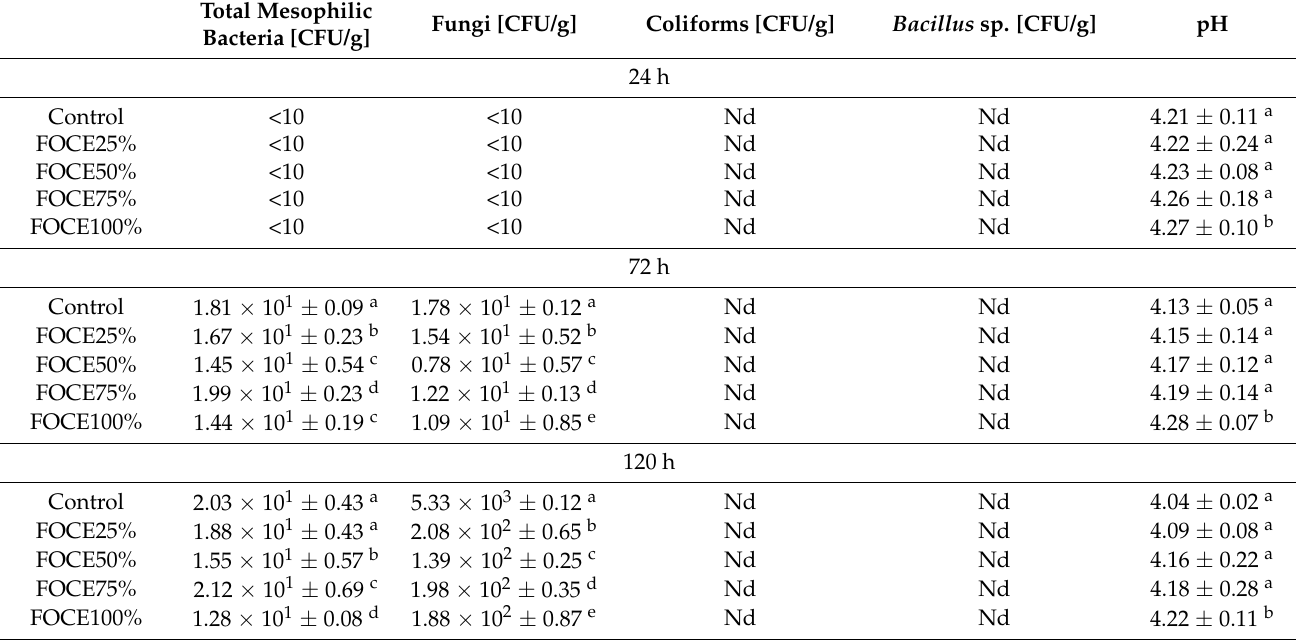
Table 3. Microbial counts and acidity of GFBs during storage